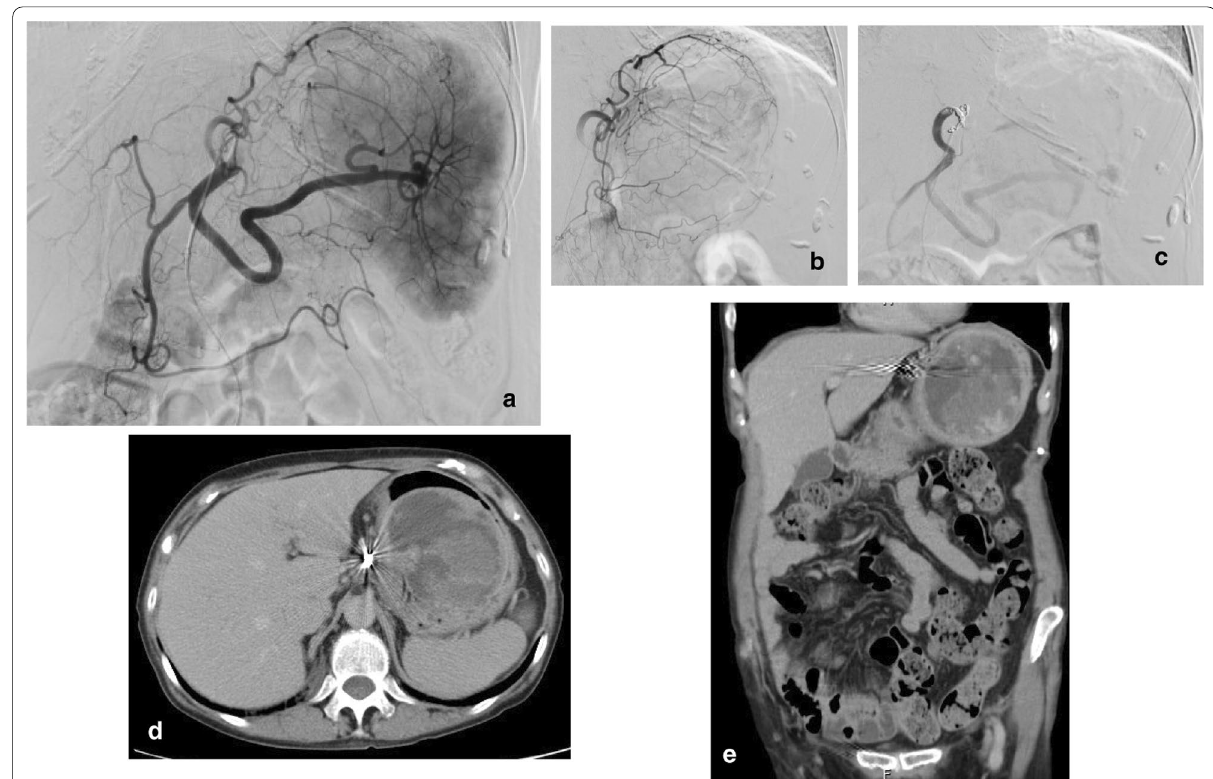
Fig. 2 a , b Thirteen days after admission, angiogram of celiac artery and left gastric artery showed a hypovascular tumor surrounded by tumor vessels originated from the left gastric artery. Extravasation could not be detected. c Embolization with stainless steel coils and gelatin particles was performed successfully. Final angiogram showed relative stasis of the left gastric artery. d , e Axial and reconstructed coronal CT after TAE showed a large cystic tumor involving the gastric fundus and coils in the left gastric artery